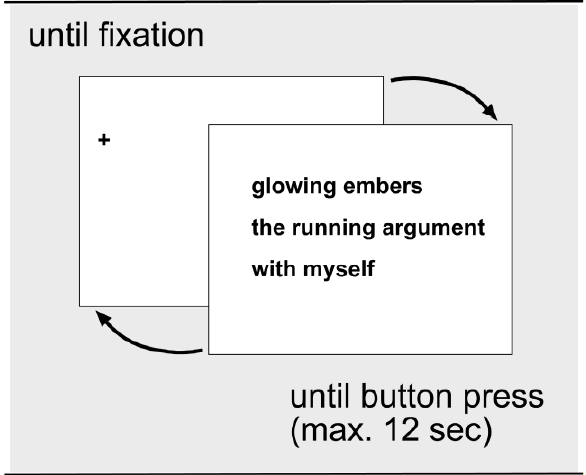
Figure 2. Trial events in the reading phase. Example display screen, with fixation cross. The poem depicted is by S. Pierides (Tinywords,